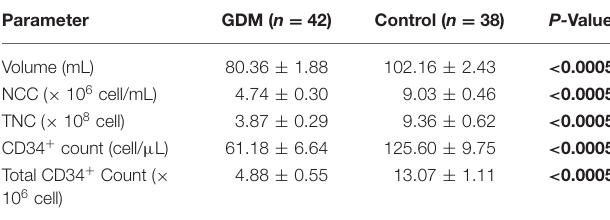
Frontiers in Medicine |